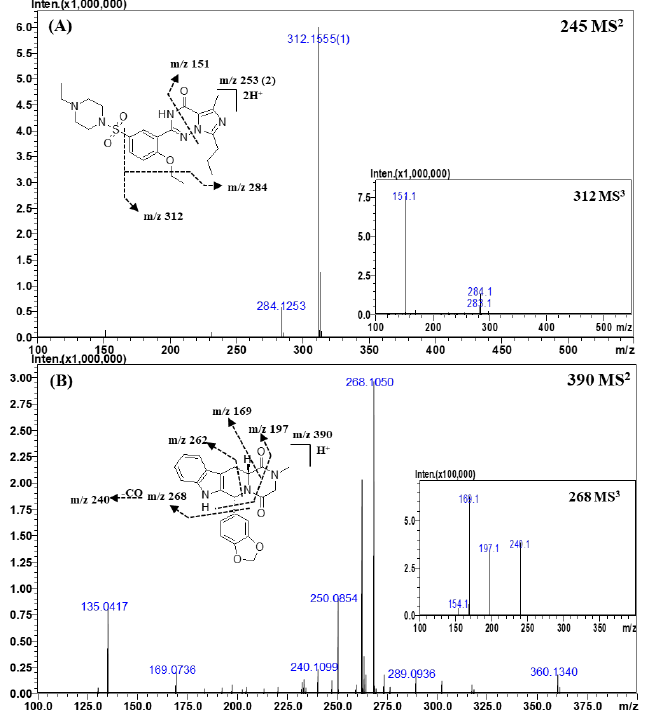
Figure 3. Representative MS n ( n = 2, 3) spectra and proposed fragmentation mechanisms of vardenafil ( A ) and tadalafil ( B ). The bracketed numbers next to the m / z values indicate the charge state of the ions.